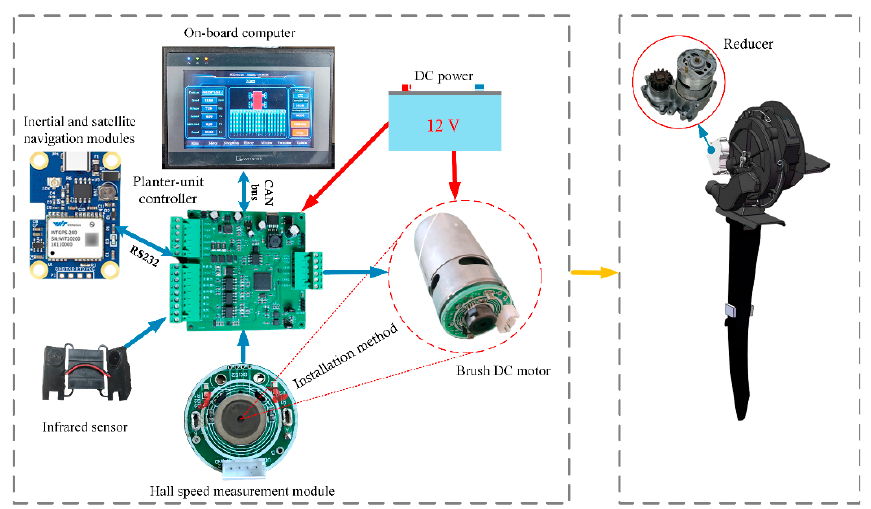
Figure 1. Planter monitoring